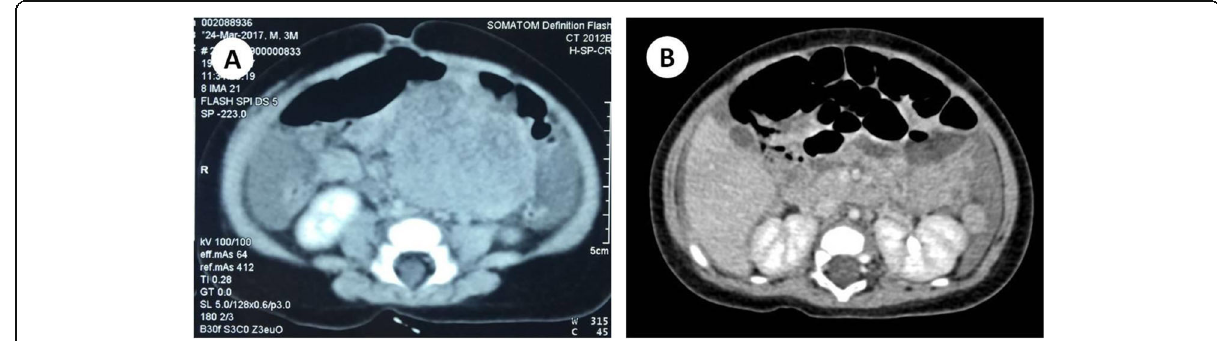
Fig. 1 Radiologic findings of the horizontal views. a : Enhanced CT showing a 6.3 × 4.6 cm mass in the left lower retroperitoneal with a clear boarder. b : Enhanced CT findings suggested that multiple metastases were seen in